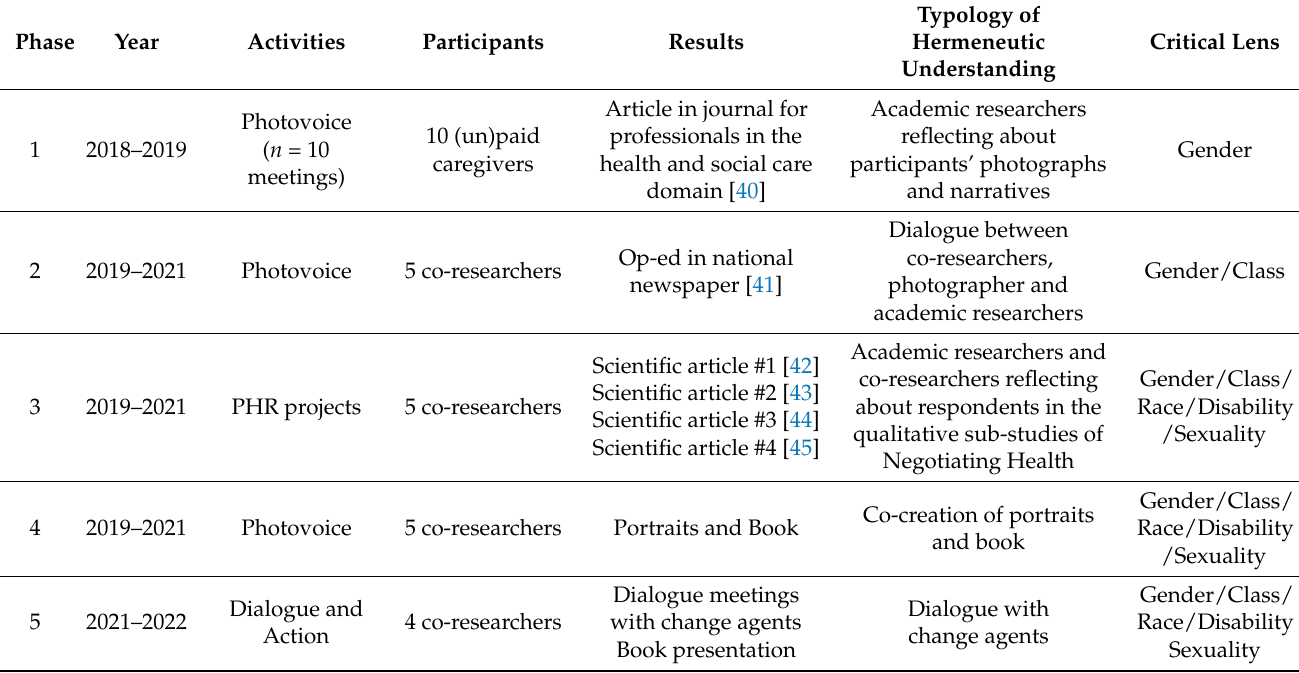
Table 1. Phases of PHR project Negotiating Health